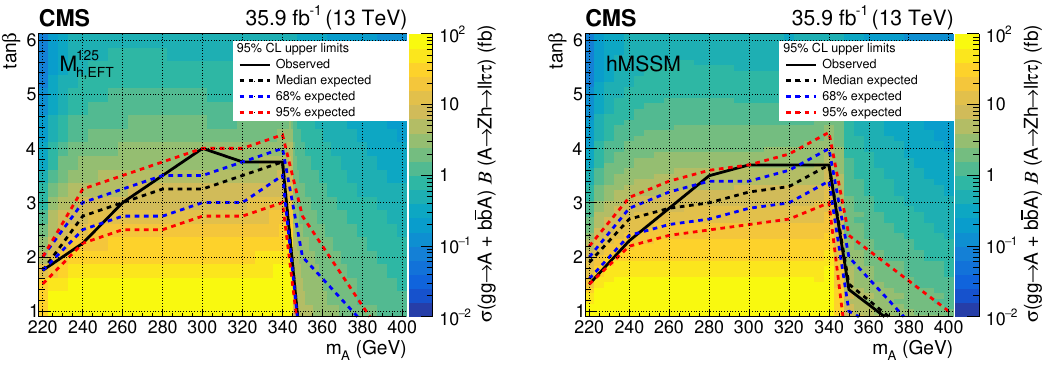
Figure 6 . The expected and observed 95% CL exclusion limits in the m {tan (cid:12) plane are shown A for two MSSM scenarios: M 125 (left) and hMSSM (right). The area under the solid black curve h ; EFT is excluded. The dashed black curve corresponds to the median expected limit, surrounded by the 68 (95)% con(cid:12)dence intervals in blue (red). The limits are overlaid on a background showing the (cid:27) (gg ! A + bbA) B (A ! Zh ! ‘‘ tt ) as predicted by each model at each grid point. scenarios, M 125 and hMSSM. In the M 125 (hMSSM) scenario, the observed limits h ; EFT h ; EFT exclude tan (cid:12) values below 1.8 (1.6) at m = 220 GeV and 4.0 (3.7) at m = 300 GeV at A A 95% con(cid:12)dence